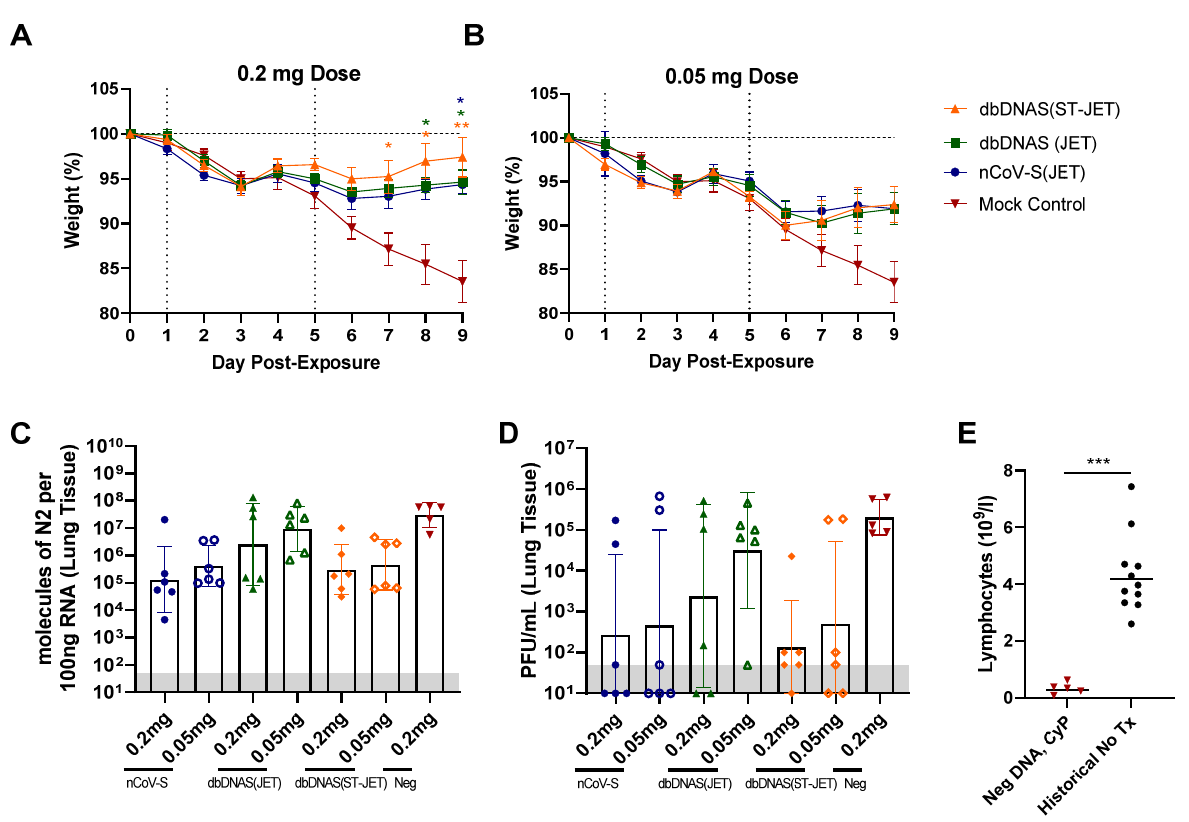
Figure 2. Protective efficacy of DNA vaccines in SARS-CoV-2 hamsters. Vaccinated hamsters from Figure 1 were treated with cyclophosphamide and exposed to SARS-CoV-2. ( A , B ) Weights were monitored daily. Individual hamster values are shown as symbols. Asterisks above and below indicate statistical significance compared with negative DNA vaccine controls and are color coated for weights to designate group. Lung tissue was analyzed by ( C ) real-time RT-PCR and ( D ) plaque assay. ( E ) Lymphocyte counts were assessed from whole blood collected at 9 dpi and compared with historical, untreated hamster controls (***, p < 0.001; **, p < 0.01; *, p < 0.05). The assay limit for panels C and D is shaded grey.